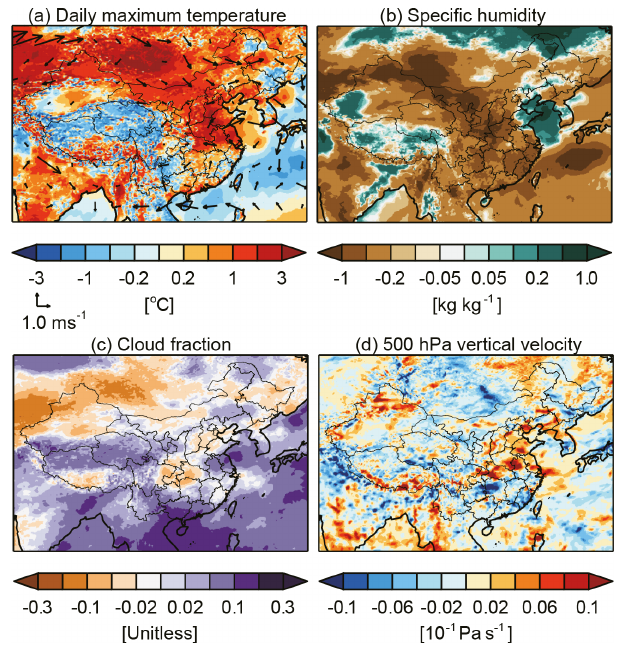
Figure 12. Differences in May–August mean (a) daily maximum 2m air temperature with 850hPa wind vectors over-plotted, (b) spe- cific humidity, (c) cloud cover faction, and (d) 500hPa vertical ve- locity between 2017 and